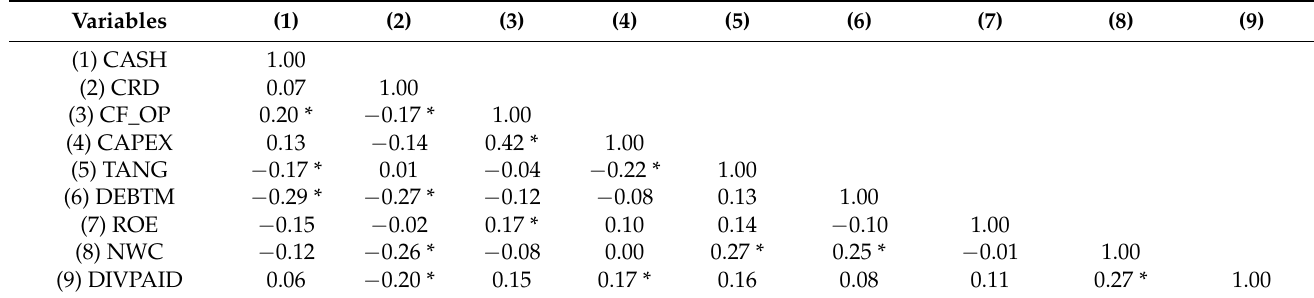
Table 5. Correlations matrix.